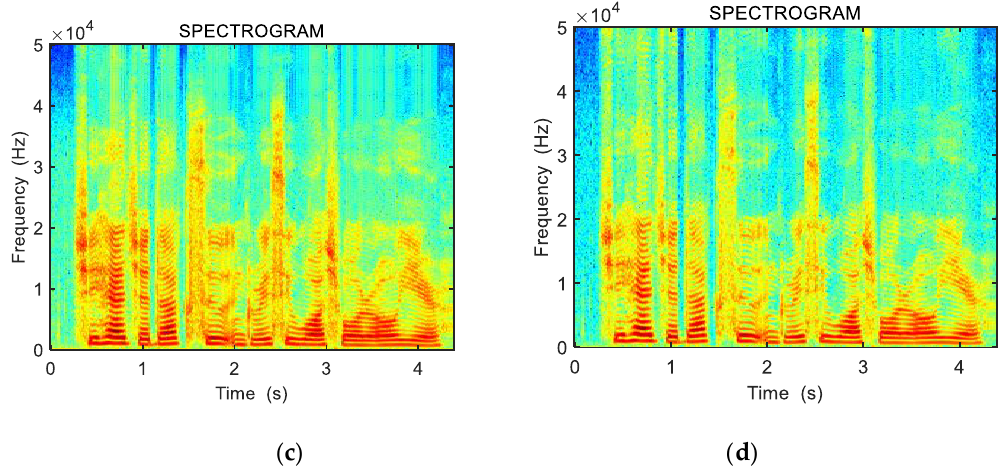
Figure 3. Spectrograms under different interpolation methods. ( a ) Resampled speech generated by zero-complementing interpolation; ( b ) resampled speech generated by linear interpolation; ( c ) resampled speech generated by spline interpolation; ( d ) resampled speech generated by cubic interpolation.